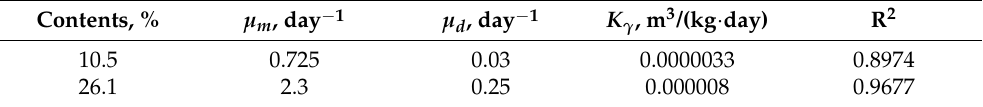
Table 2. The coefficients of the simulation model of biogas output during cattle manure digestion with the addition of a molasses broth at a fermentation temperature of 40 ◦